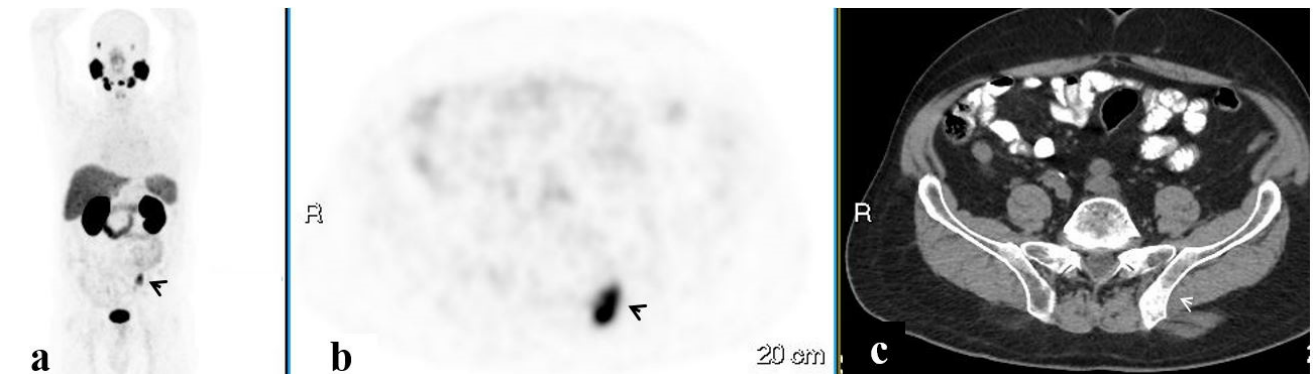
Figure 4. A PSMA-avid lesion in the pelvis at the prostatic bed. 68Ga-PSMA scan, PET ( a ) and CT ( b ) axial slices demonstrating focally increased uptake in the pelvis at the prostatic bed on the left (arrows).